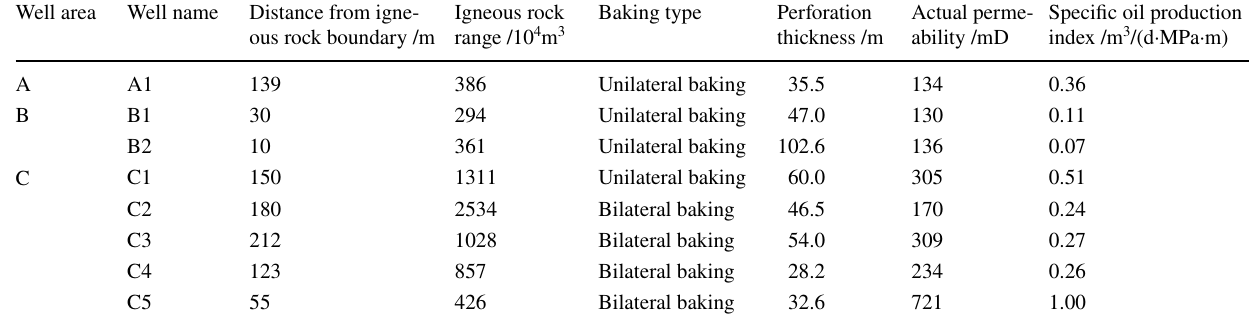
igneous rock at the edge igneous rock at the bottomsandstone reservoir